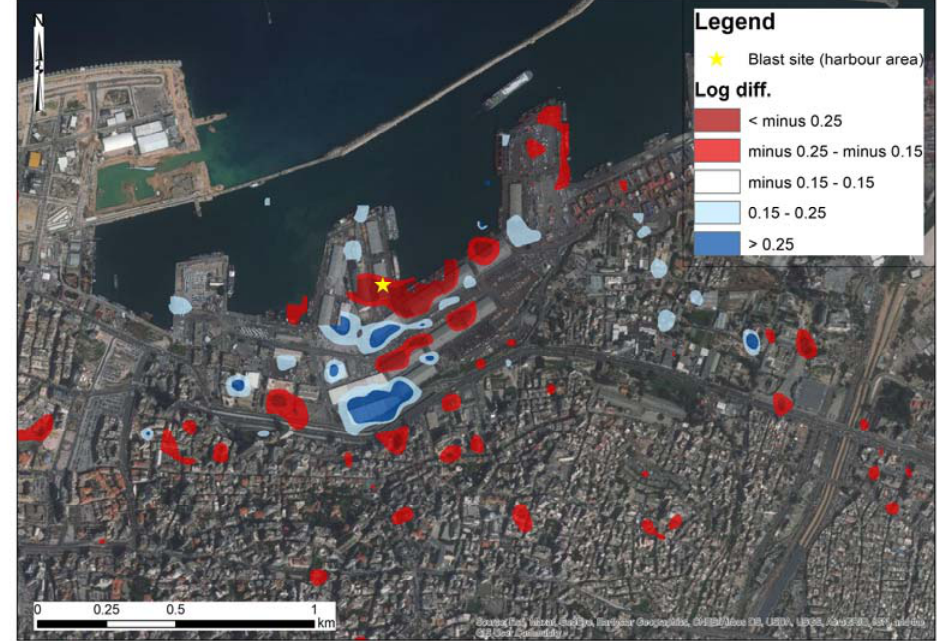
Figure A3. Change detection results as shown in Figure A1 (see before) for the area around the blast site near the harbor of Beirut (indicated with a white dashed line in Figure A1). The location of the blast size is shown with the yellow star.